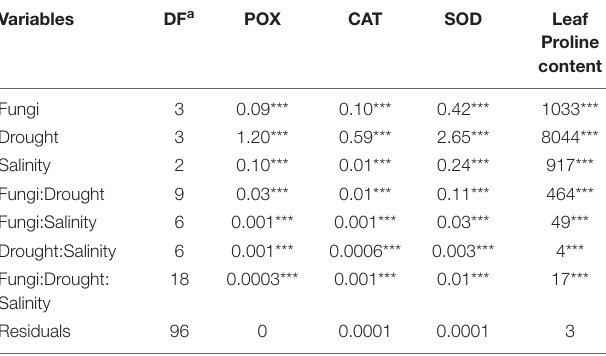
TABLE 2 | Three-way analysis of variance (ANOVA) of the effects of the halotolerant fungal endophytes, P. macropinosa , N. goegapense , and N. chichastianum on the activity of antioxidant enzymes including POX, CAT, and SOD, and leaf proline content of Hordeum vulgare L. (barley) under different levels of salinity and drought stresses.